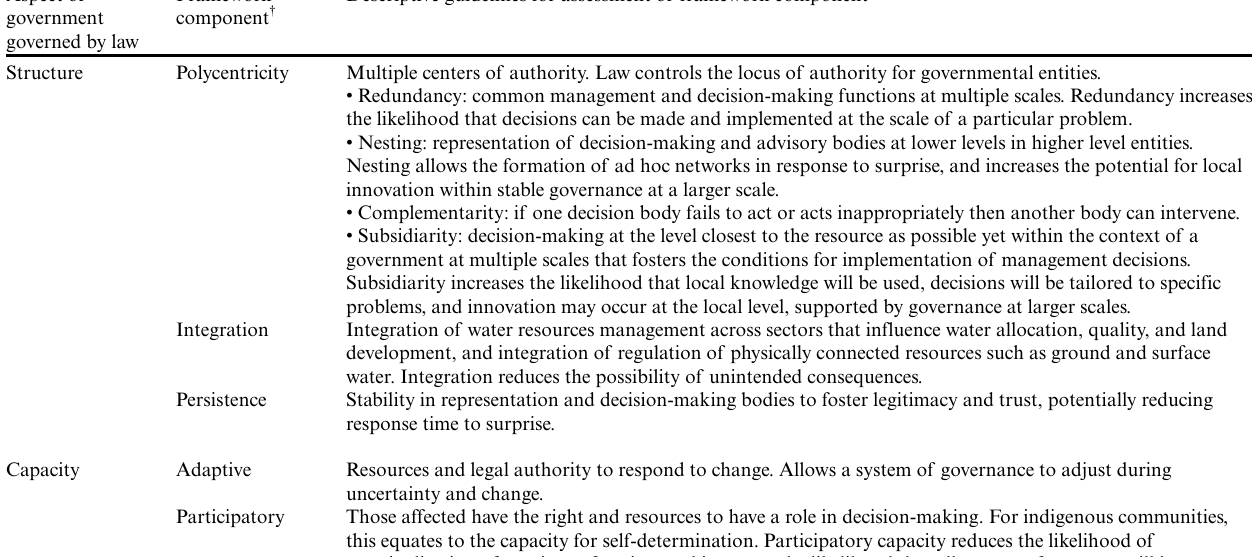
Table 1. Guidelines for inquiry into the role of law in adaptive